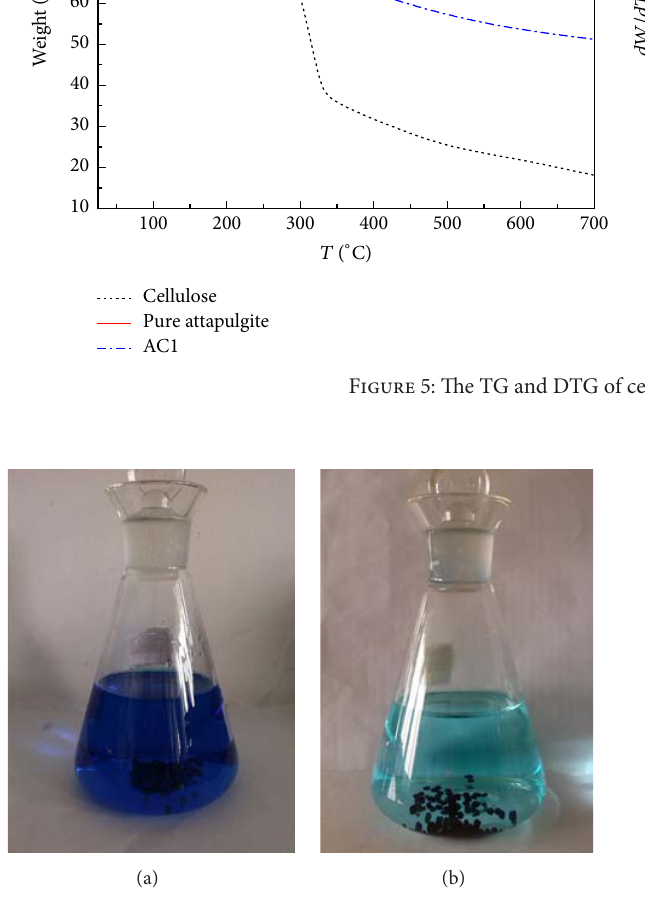
Figure 6: The methylene blue adsorption effect of 0.5 g AC1 in 200 mL 12.016mg L −1 methylene blue solution for 48h ((a) before adsorption and (b) after adsorption).